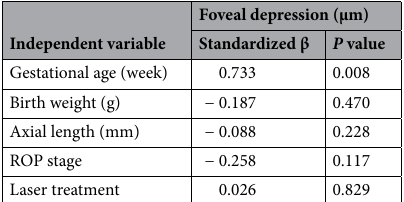
Independent variable